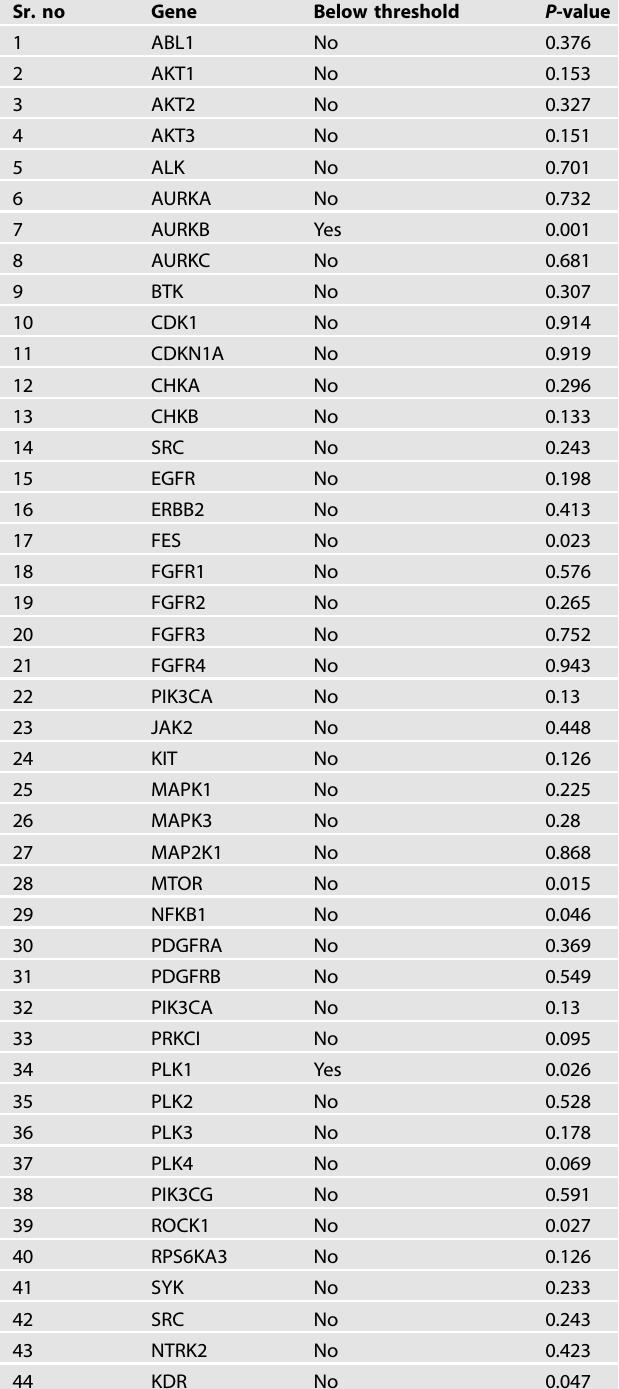
Table 2. Expression of various kinases in AA and EA patients with TNBC (TCGA